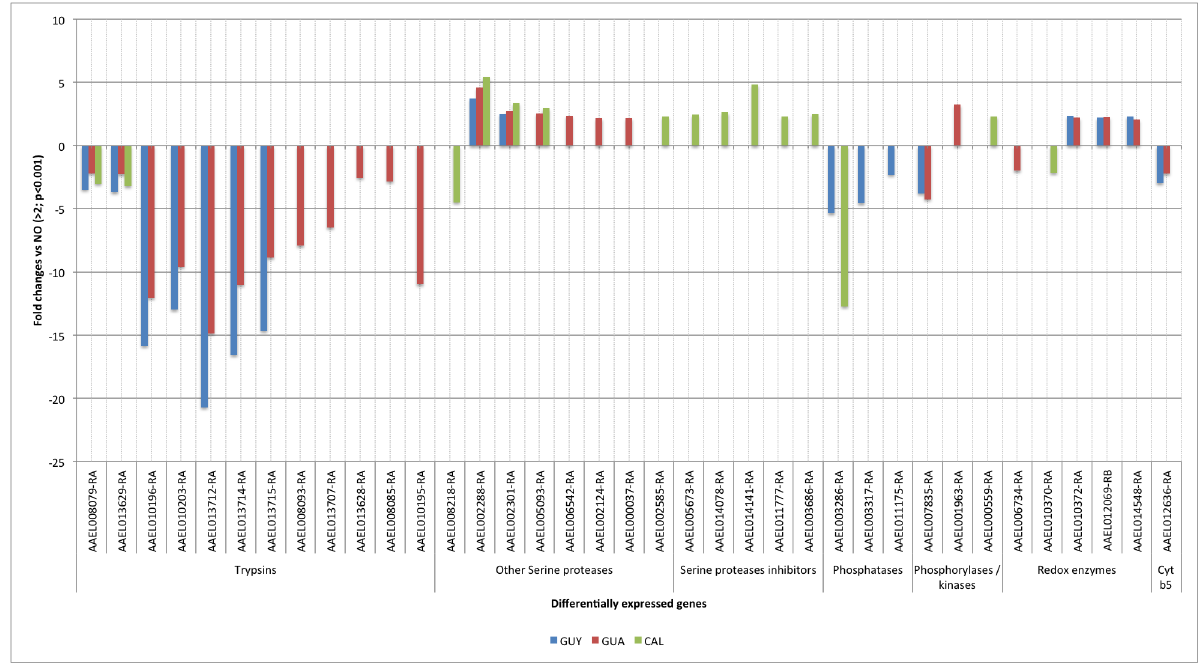
Fig 3. Fold changes of differentially expressed genes with a putative role in detoxification gene regulation or transformation of their products relative to the susceptible NO strain (Fold change > 2; p < 0.001).